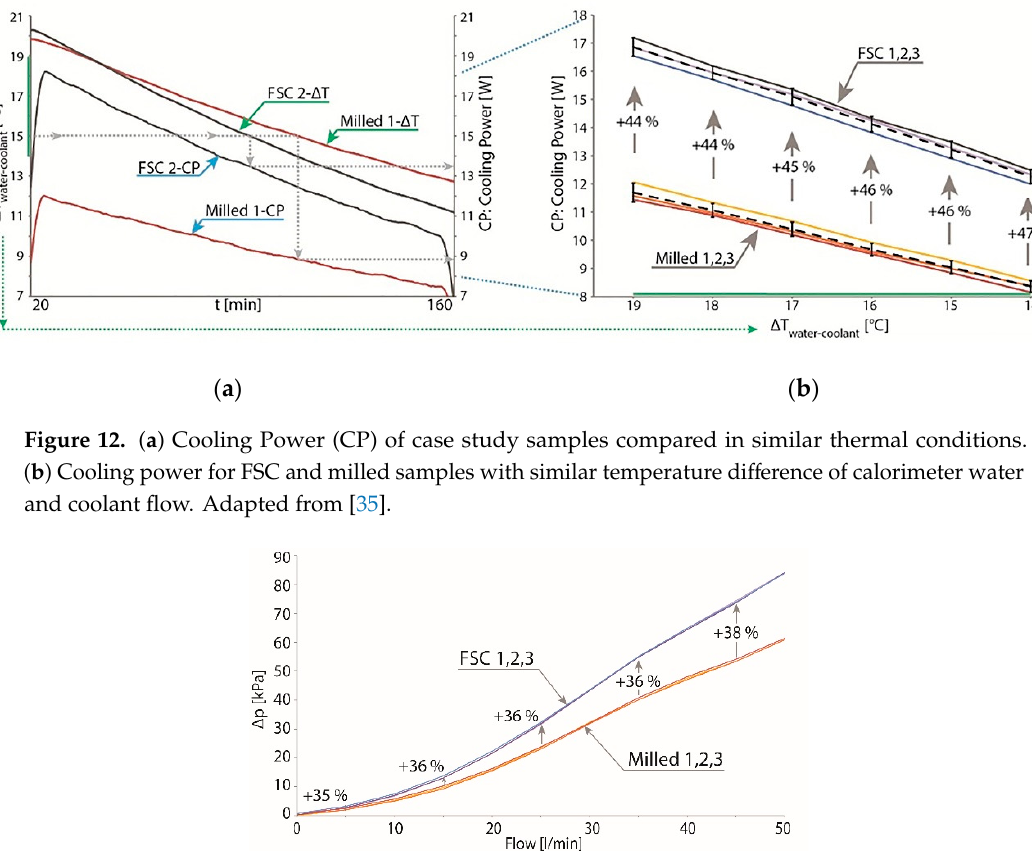
Figure 13. Pressure difference over the FSC and milled samples with 0–50 l/min flow for case study samples. Adapted from [35].